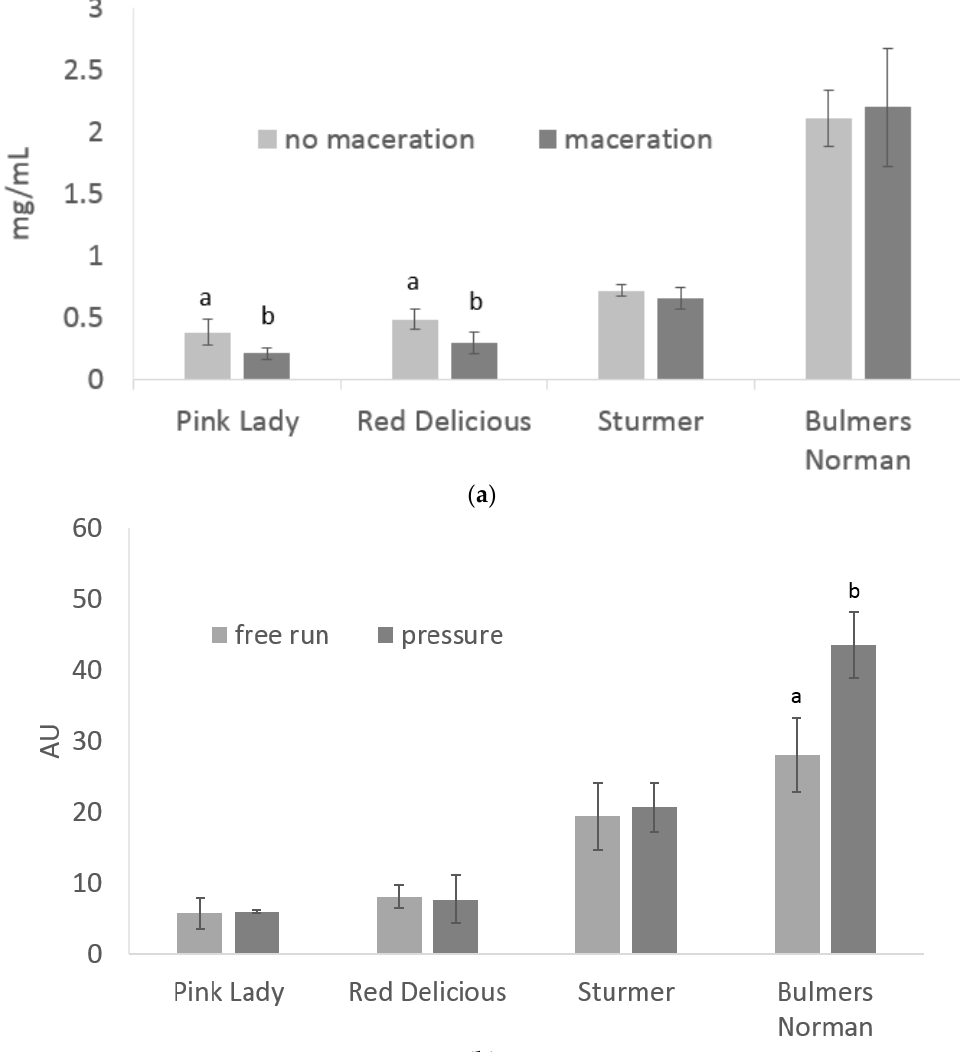
Figure 1. Total Phenolic content of juice extracted from four apple varieties as impacted by pre-fermentation treatment maceration, measured by the Folin–Ciocalteu method in p -coumaric acid equivalents mg/mL ( a ) and press fractions as measured by spectrophotometric absorbance at 280 nm (A280) in AU ( b ).